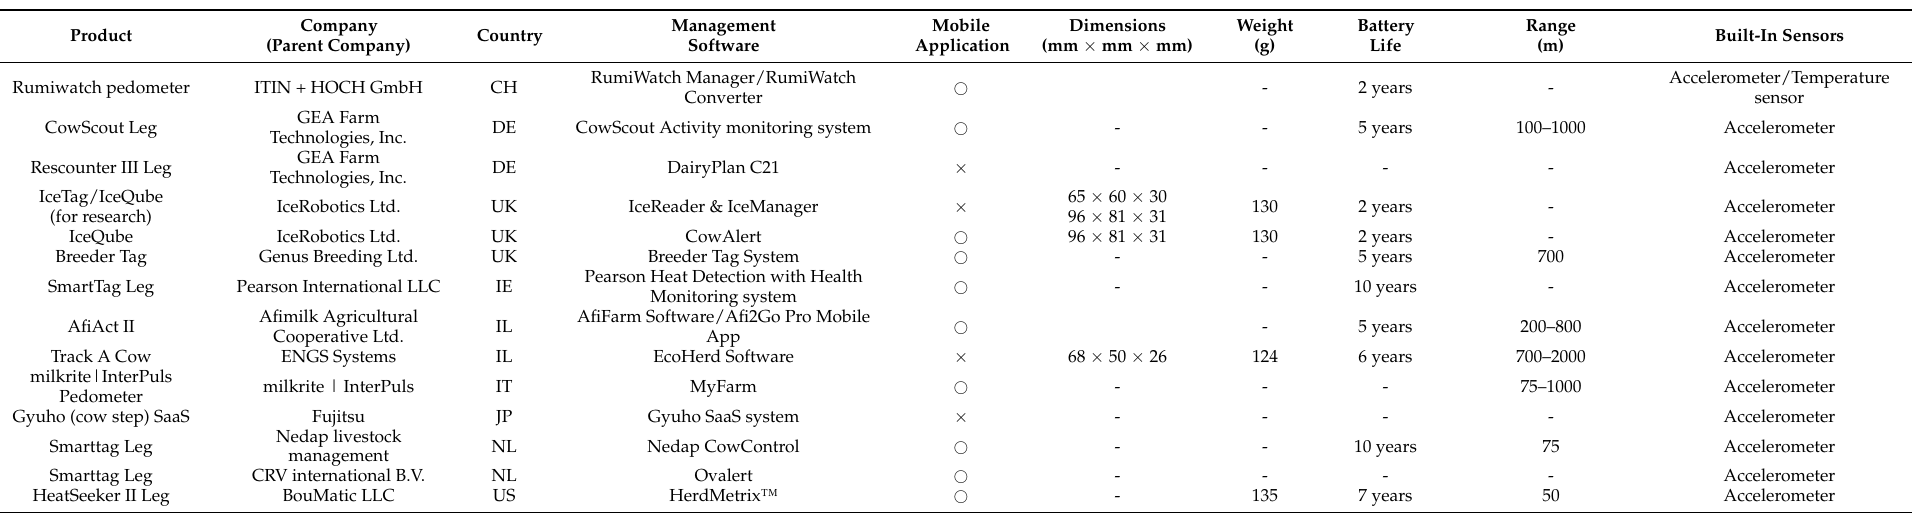
Table 7. Information about currently available leg-tag type